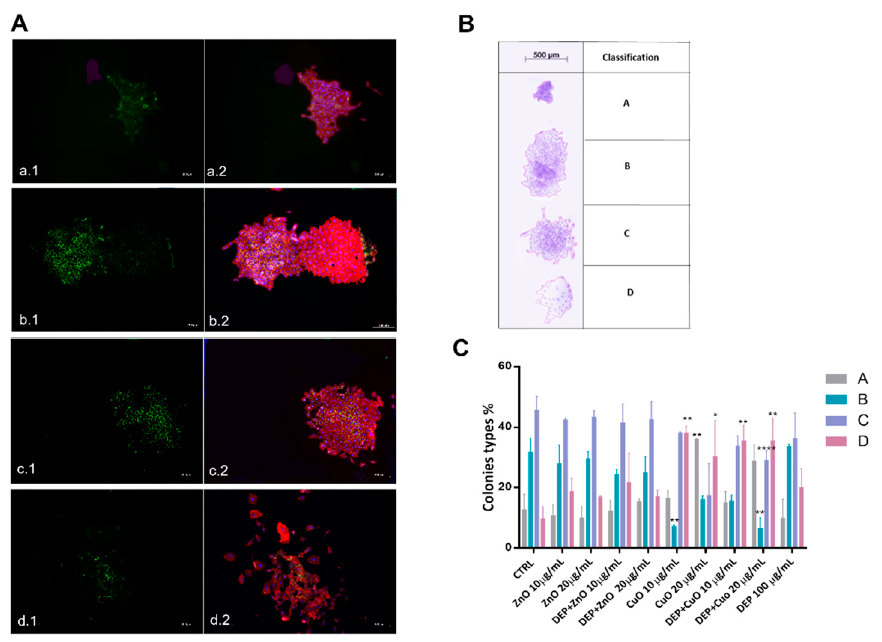
Figure 4. Colonies’ classification and the percentage prevalence of each colony type after cells’ exposure to particles. Panel ( A ) shows fluorescence microscope images of colonies stained for E-cadherin (Green) (a.1; b.1; c.1; d.1), rhodamine phalloidin (Red), and DAPI (Blue) (a.2; b.2; c.2; d.2). Colonies’ classification according to their shape and cellular contacts is shown in panel ( B ). Histograms representing the percentage of colonies in the four groups (A, B, C, and D) are represented in panel ( C ). Statistical analysis was performed using one-way ANOVA with Dunnett’s multiple comparisons tests. ** p < 0.01, * p < 0.05, and **** p < 0.0001 vs. control.